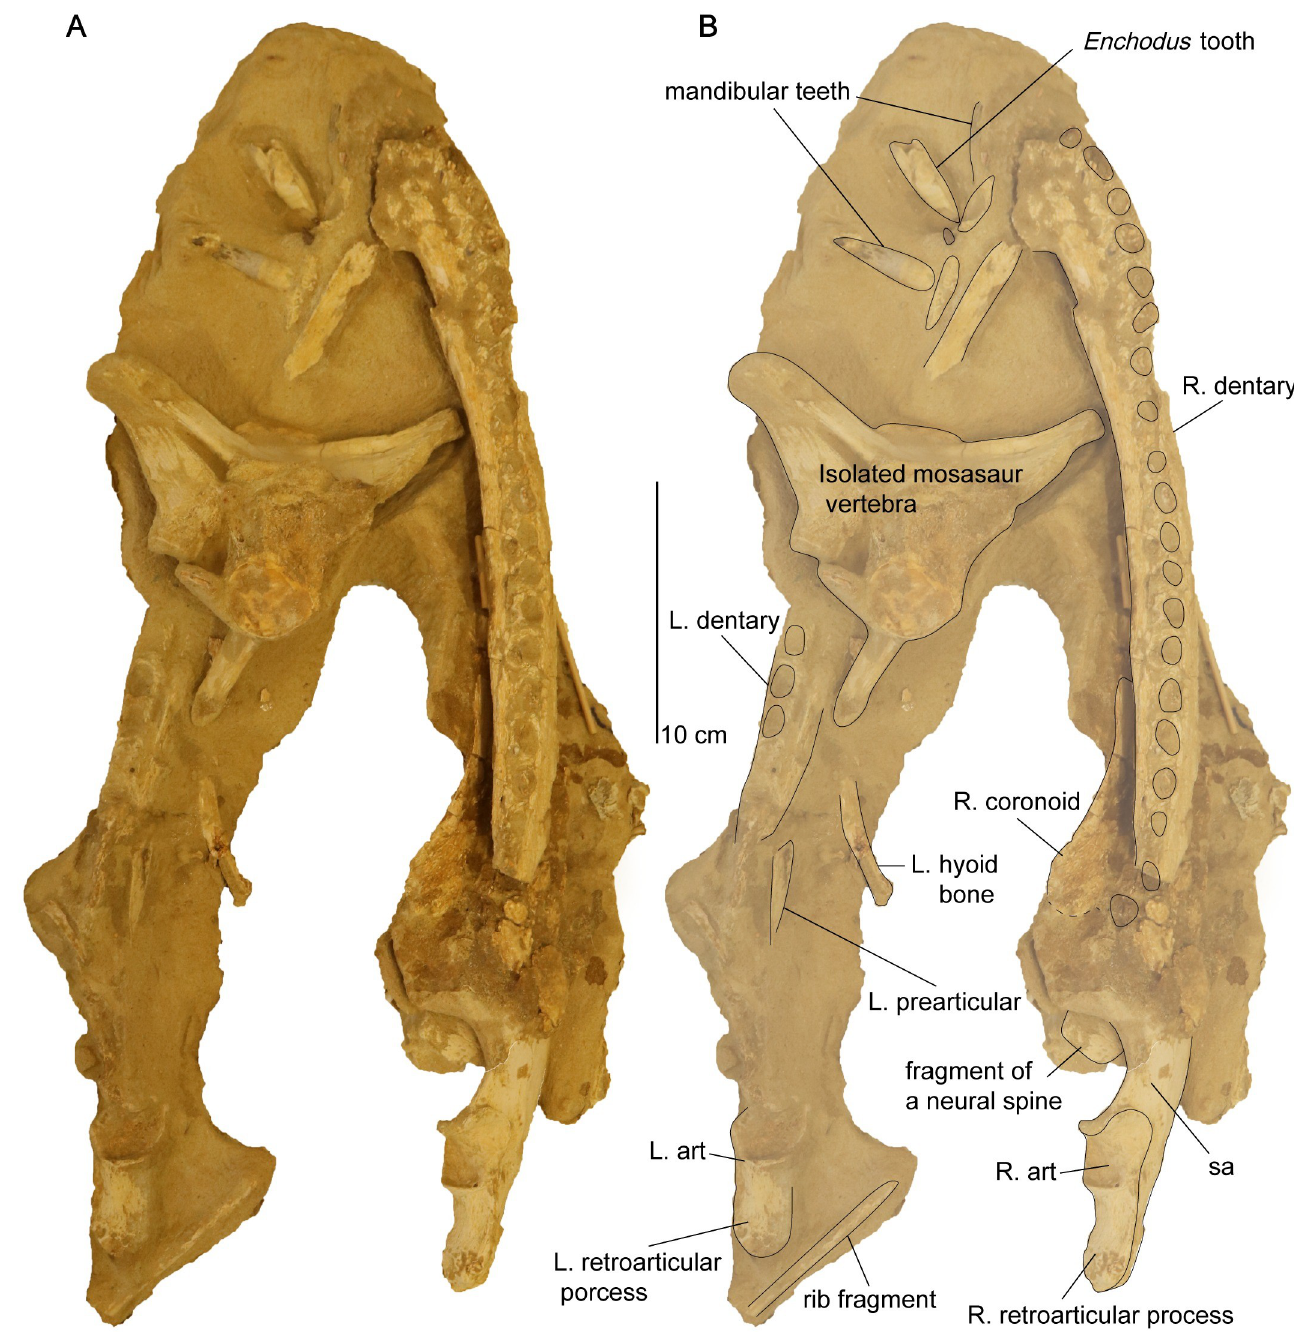
Fig 15. Dorsal view of the mandible from Cardiocorax mukulu (MGUAN PA278). A. Uninterpreted view. B. Individual bone elements labeled. Articular . The articular forms the mandibular glenoid and is contacted medially by the pre- articular, anteriorly by the surangular, and ventrally by the angular (Figs 14 and 16). Posteri- orly, the articular forms the dorsal margin of the retroarticular process (Fig 14).